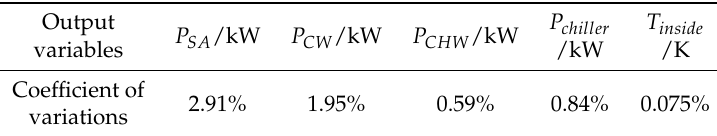
Table 2. The coefficients of variation (CVs) of output